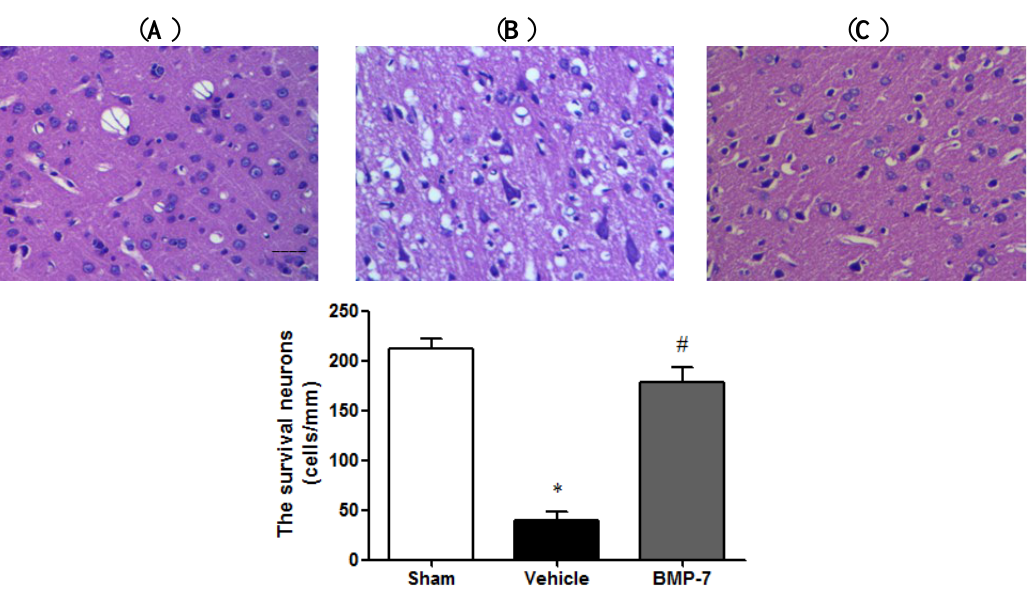
Figure 3. Morphological examinations of cortex neurons by hematoxylin and eosin staining (scale bar = 20 μm). ( A ) sham group; ( B ) vehicle group; ( C ) BMP-7 group. BMP-7 treatment increased the number of surviving neurons and ameliorated the extent of damage in the cortex. Data were expressed as mean ± SD ( n = 10). * p < 0.05 versus sham group; # p < 0.05 versus vehicle